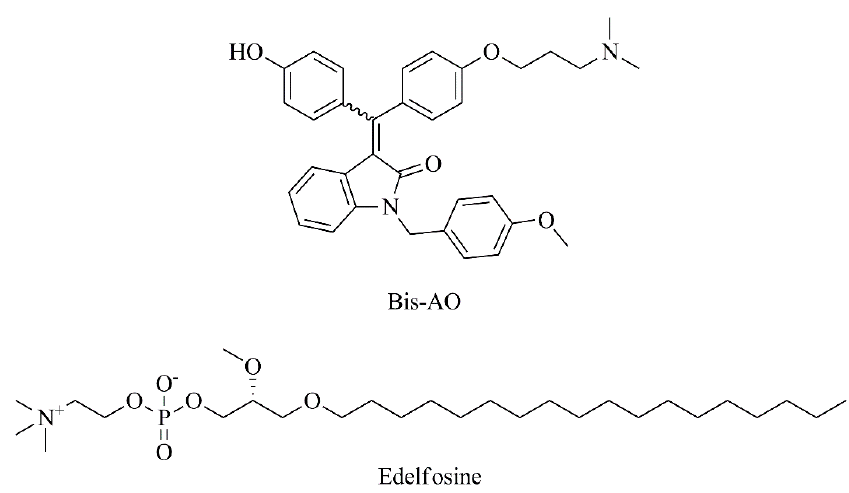
Figure 10. Chemical structures of bis-arylidene oxindole (Bis-AO) and edelfosine.